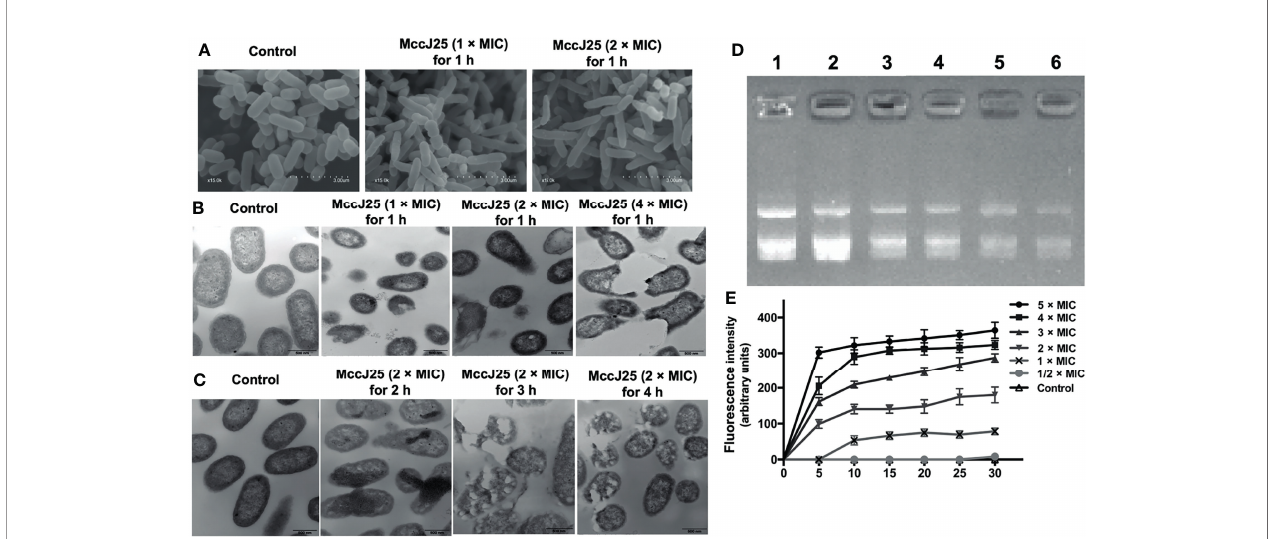
FIGURE 2 | Potential mode of action of MccJ25. (A) Morphological analysis of the ETEC K88 membrane with MccJ25 by scanning electron microscopy. 10 7 CFU/ mL of ETEC K88 cells were treated with different concentrations (1, 2 × MIC) MccJ25 for 1 h, scanning electron microscope was performed to test the change of morphology. (B) Transmission electron microscopy micrographs of ETEC K88 cells treated with different concentrations of MccJ25 for 1 h (C) . TEM micrographs of ETEC K88 at 2 × MIC concentrations of MccJ25 for different durations. (D) The interrelationship that exists between the peptide and plasmid DNA. The speci fi c status of binding was clari fi ed by measuring the inhibition exerted on the migration of plasmid DNA. Various amounts of MccJ25 were incubated separately with 400 ng of MccJ25 for one hour at room temperature prior to electrophoresis on a 1.0% agarose gel. The weight ratios (MccJ25:DNA) are expressed as follows: lane 1, plasmid DNA alone; lane 2, ratio 1:4; lane 3, ratio 1:2; lane 4, ratio 1:1; lane 5, ratio 2:1; lane 6, ratio 4:1. (E) Time dependence of Sytox Green in fl ux into E coli K88 cells. Cells were incubated with 1 M Sytox Green until basal fl uorescence was reached and maintained in a steady state. Then, MccJ25 was added, and the fl uorescence was measured at fi xed time points (excitation and emission wavelengths of 485 nm and 520 nm, respectively). Error bars indicate mean ± standard error of mean ( P <